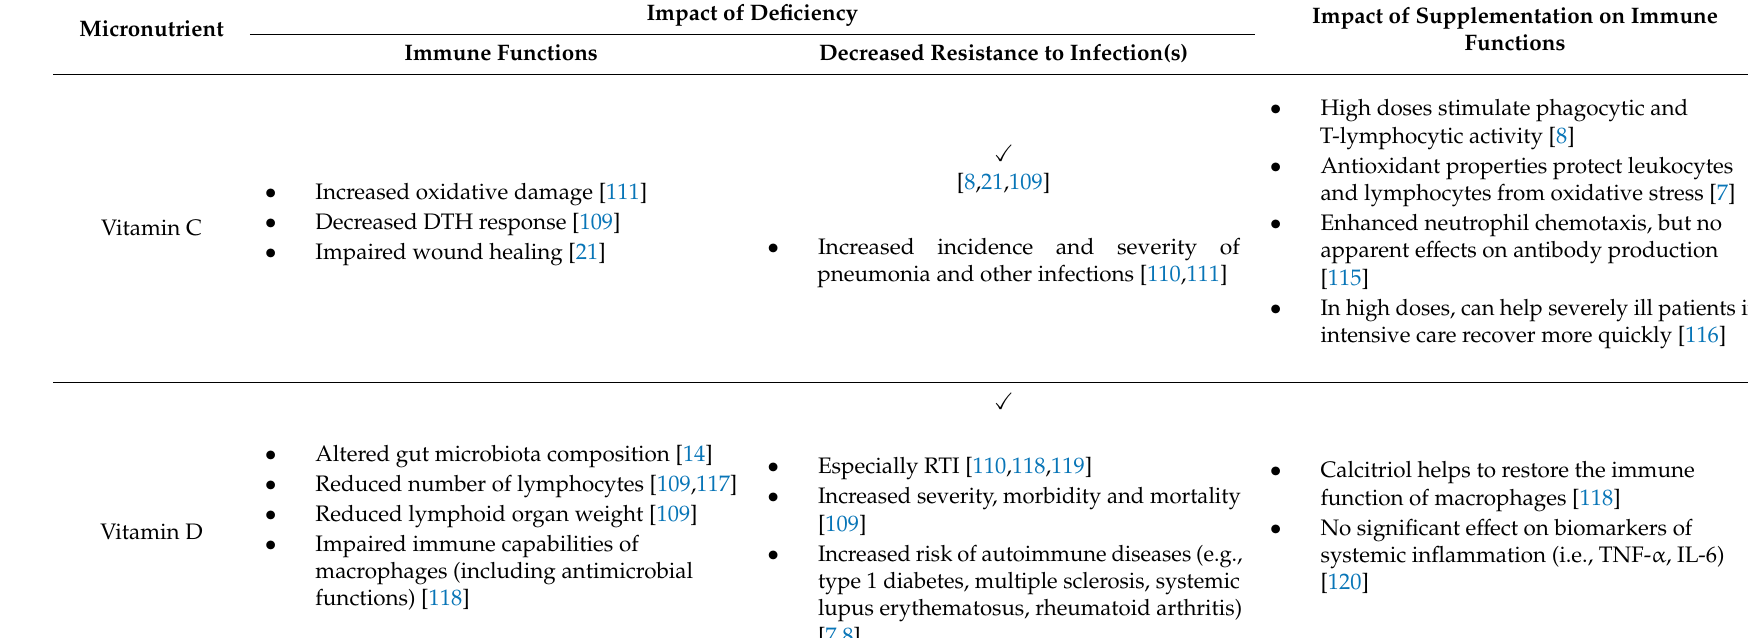
Table 2. Impact of micronutrient deficiencies and supplementation on immune